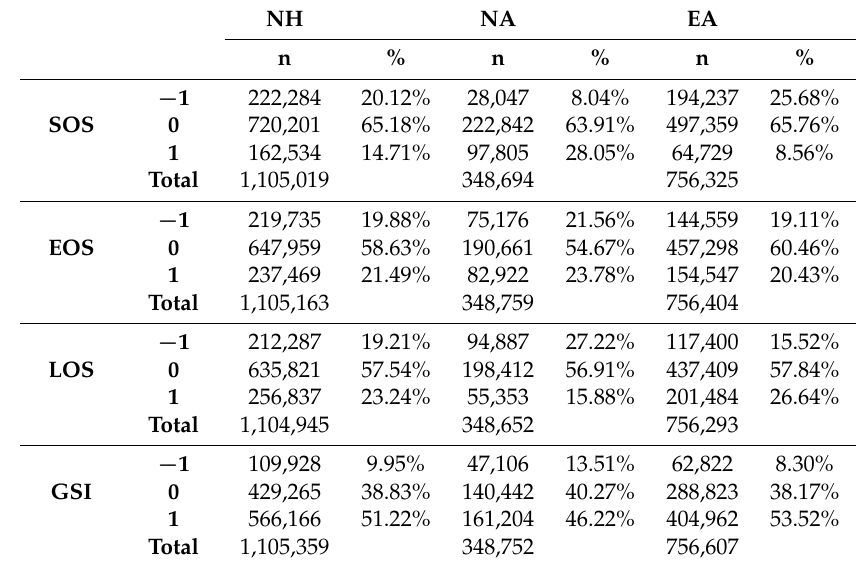
Table 2. Statistics (number of pixels and percentages) of significant trends in vegetation metrics (phenology (Figure 2A–C) and growing season integral (Figure 2D)) during 1982–2013 at hemispheric and continental scales. ( − 1: significant negative trends, +1: significant positive trends, 0: non-significant trends ( p =